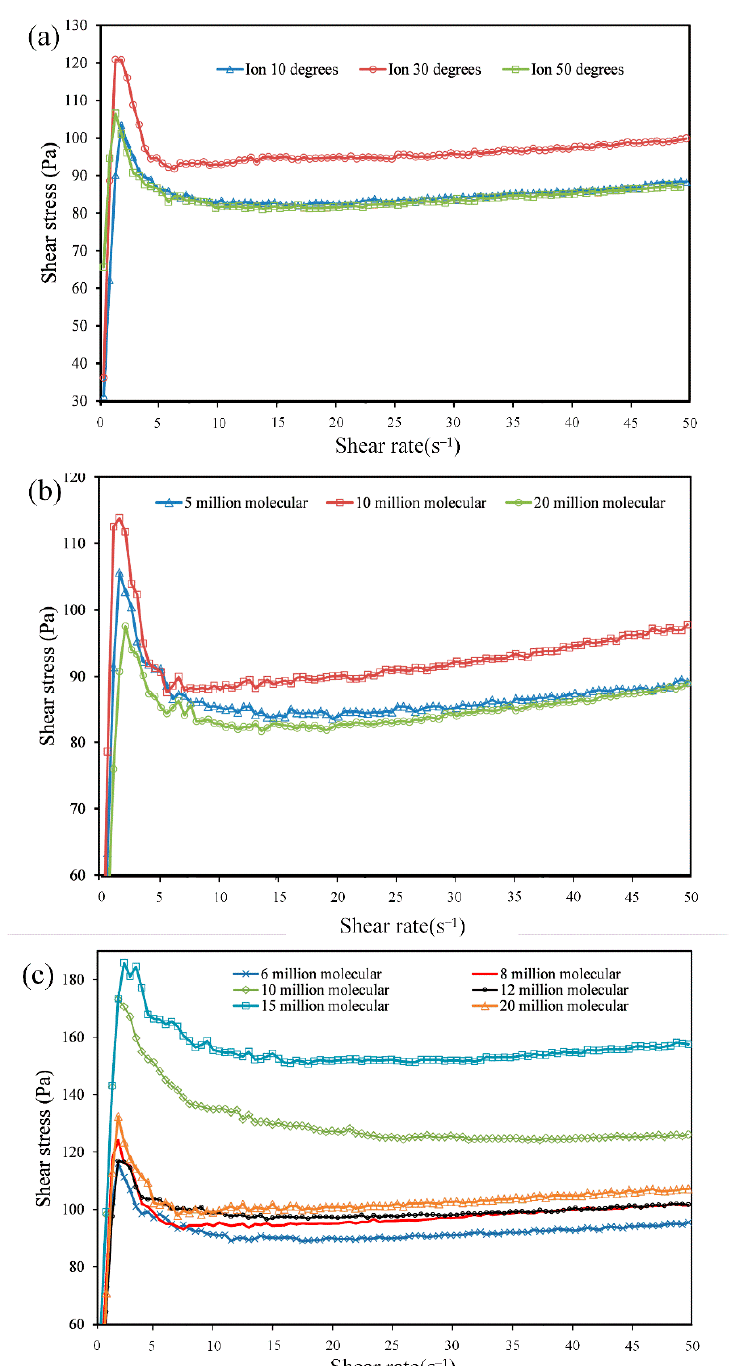
Figure 5. Flow curves of red mud with different ionic types: ( a ) cationic flocculants with different ionic degrees; ( b ) nonionic flocculants with different molecular weights; ( c ) anionic flocculants with different molecular weights.